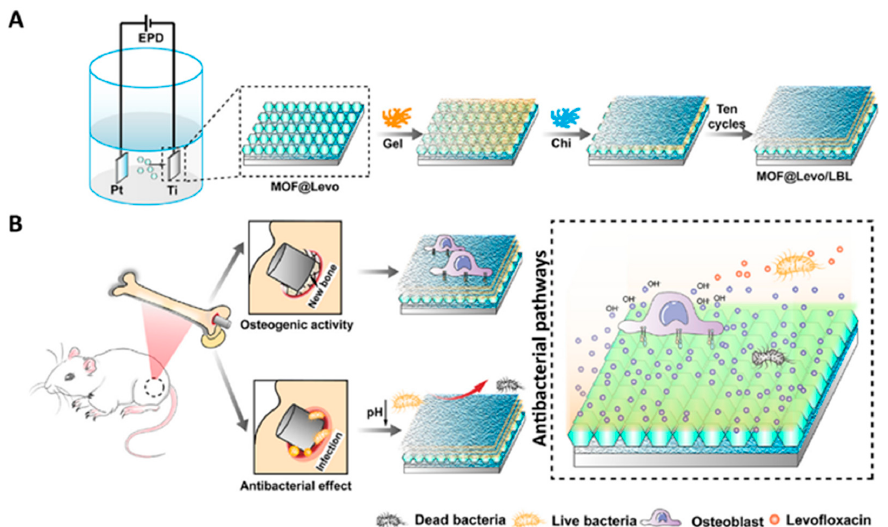
Figure 8. ( A ) Schematic illustration of ZIF-8@Levo coating onto Ti implant and ( B ) potential antibacterial pathways of the ZIF-8@Levo/LBL implant for infected femur treatment. Reproduced with permission from [72].